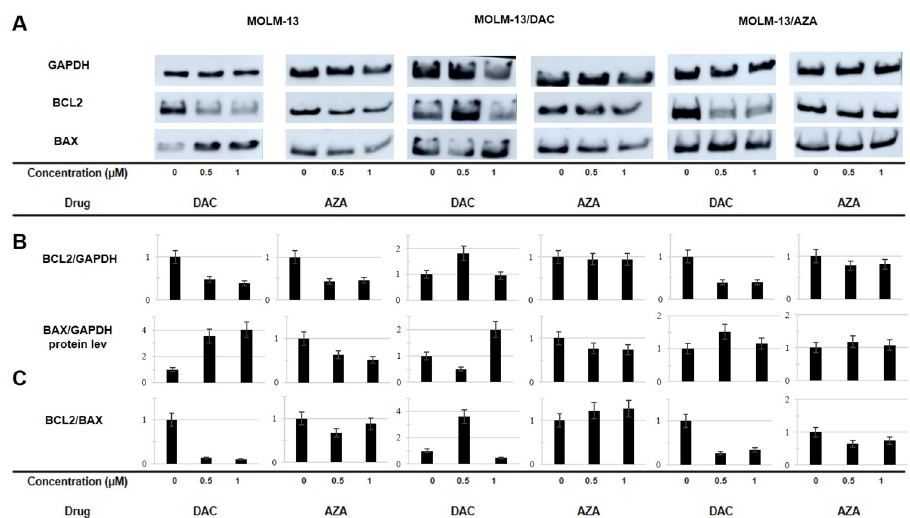
Figure 7. ( A ): Levels of BCL2 and BAX proteins in sensitive and resistant cell lines as determined by Western blot analysis. The cells were incubated for 72 h in growth medium in the absence or presence of AZA or DAC in a CO 2 incubator. The results of 24 and 48 h of incubation are shown in Supplementary file Figures S4 and S5. AZA or DAC was added to the cultivation medium every 24 h. The level of GAPDH was used as an internal control. The data are representative of three independent measurements. ( B ): The optical densities of the protein bands were quantified by densitometry and are summarized in the bar plots. The data are expressed as the mean ± SD of three independent measurements. ( C ): Ratios of BCL2/BAX proteins (as a measure of the internal pathway of apoptosis [44]) are indicated by the data in panel C.